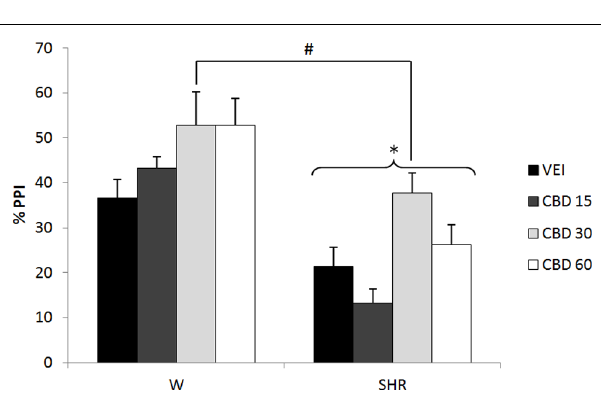
FIGURE 3 | %PPI ofWistar rats (WRs) and spontaneously hypertensive rats (SHRs) treated with vehicle (VEH), 1, 5, or 10 mg/kgAM404 (AM). * p < 0.001 compared toWRs.Three-way repeated measures ANOVA followed by Dunnett’s test. Data are reported as mean ± SE.